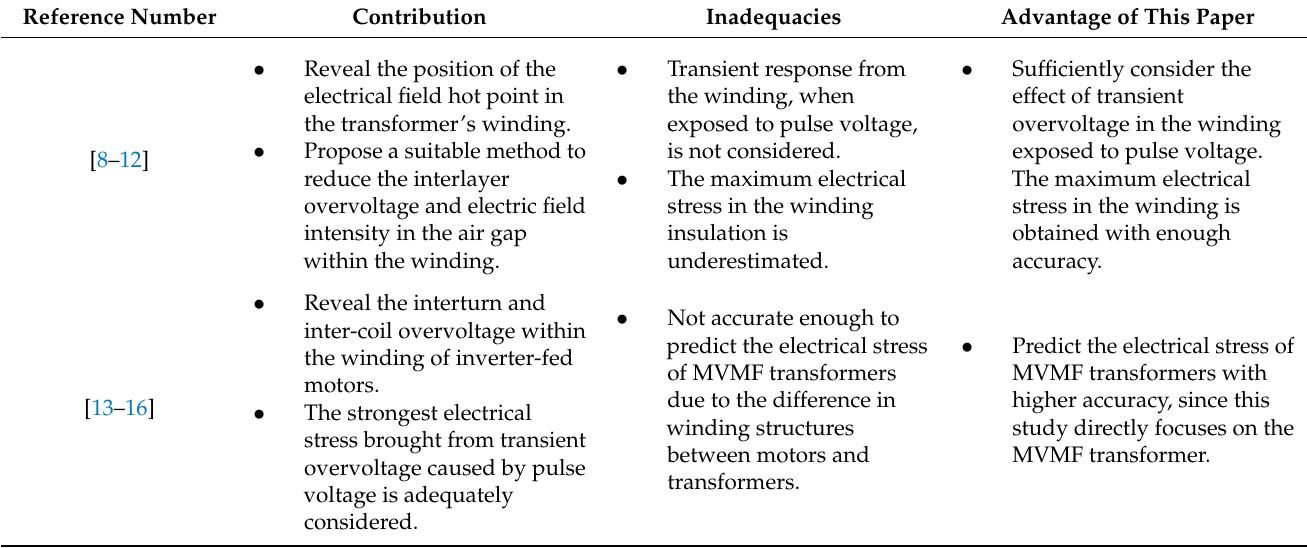
Table 1. Comparisons between reviewed studies and this paper from the perspective of an MVMF transformer. Reference Number Contribution Inadequacies Advantage of This